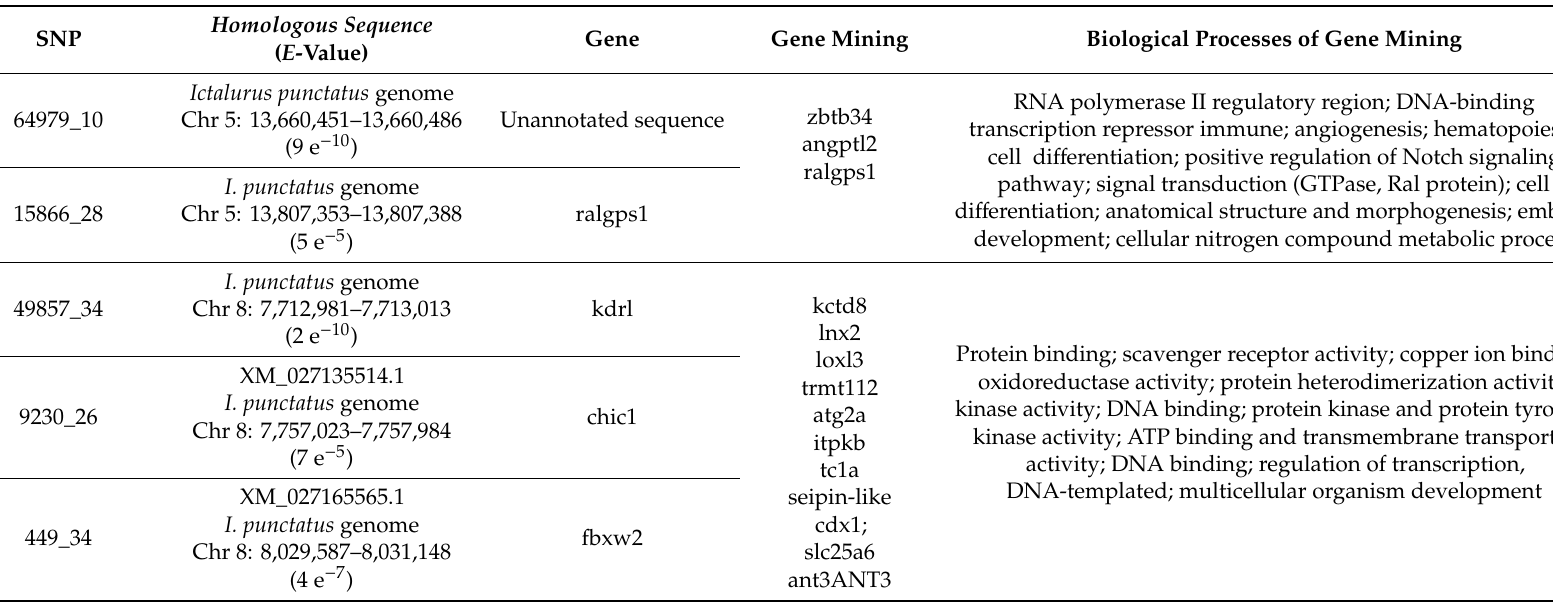
Table 2. Annotation and gene mining of the most consistent Rhamdia quelen Outlier dataset that results from comparing Northern and Southern basins.